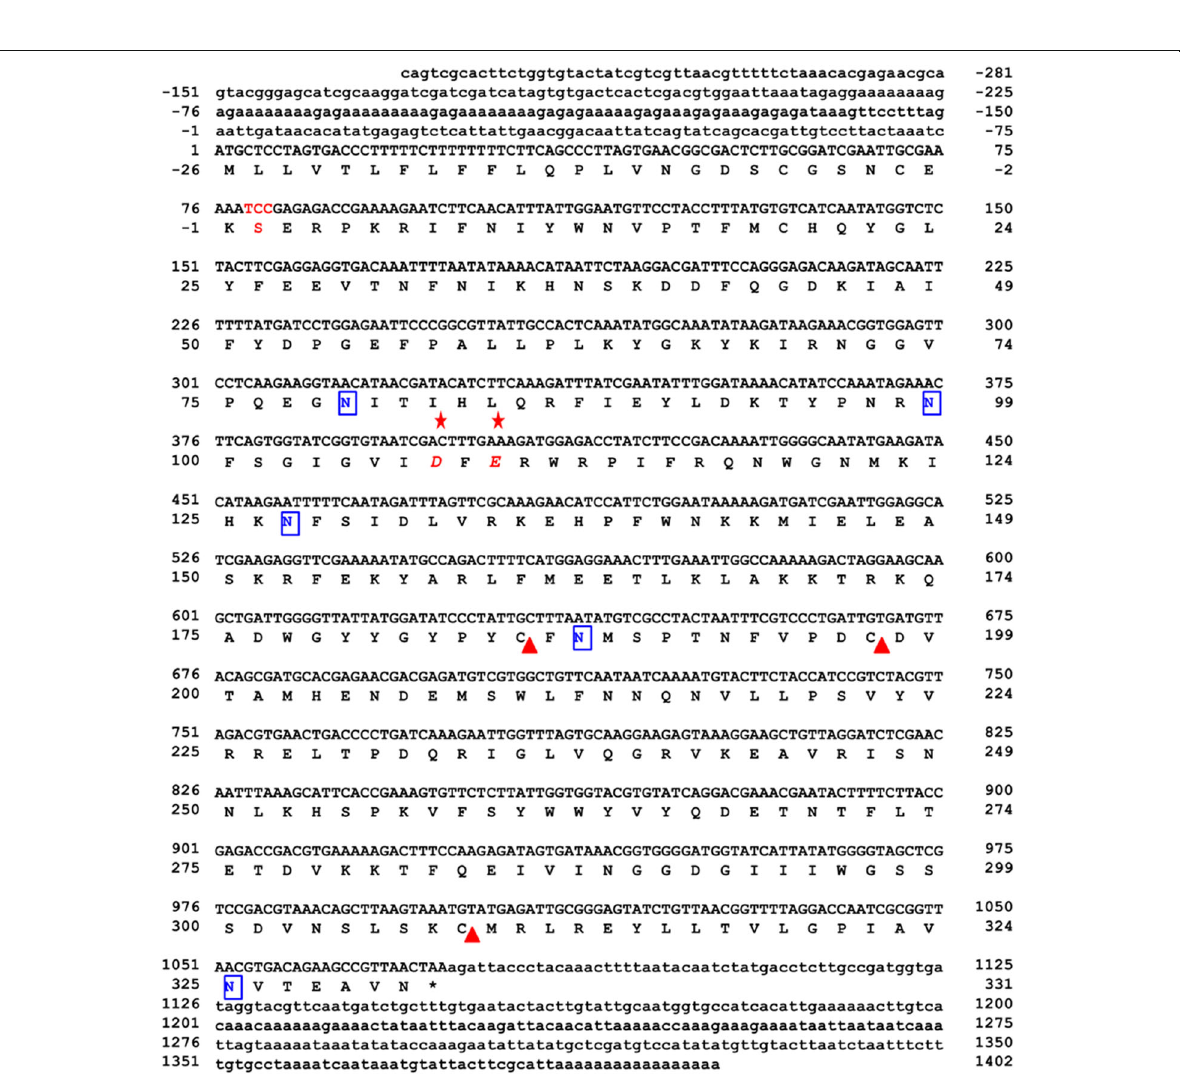
Fig. 2 The completed nucleotide sequence and deduced amino acid sequence of Vespa tropica HAase a (VesT2a). The numbering corresponded to the VesT2a sequence. The 5 ′ and 3 ′ UTRs were indicated by the small letters. The red stars ( ✩ ) (Glu and Asp) indicate active sites of HAase whose activity is highlighted by the red letters. The stop codon was indicated with an asterisk (*). Disulfide bonds were labelled with triangle marks ( △ ): (C 19 -C 308 and C 185 -C 197 ). Five potential immunogenic sites were indicated with blue boxes ( ▯